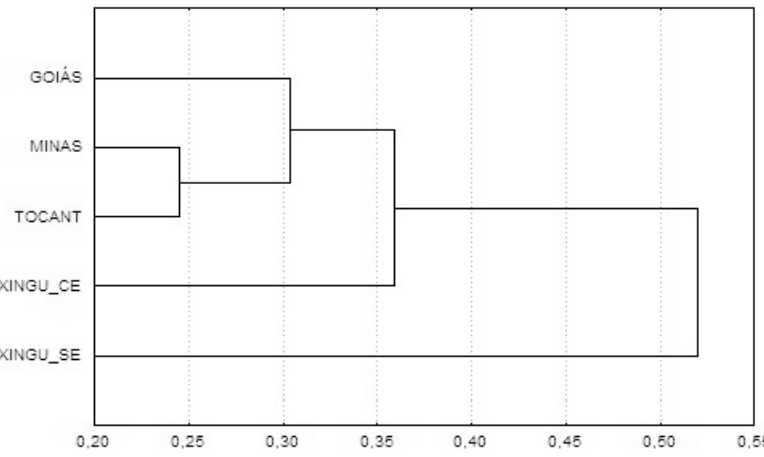
Fig. 5 – Representative dendogram of the genetic distance per percentage of disagreement and grouping by the UPGMA method among five populations of pequi ( Caryocar brasiliense ) of the Brazilian savannah using 53 primers. Goiás: Corumbaíba – GO (Fazenda Arrependidos); Minas: Uberlândia – MG (Clube Itororó Caça e Pesca de Uberlândia); Tocantins: Porto Nacional – TO; Xingu_CE: São José do Xingu – MT (pequi with thorn); Xingu_SE: São José do Xingu – Mato Grosso – MT (pequi without